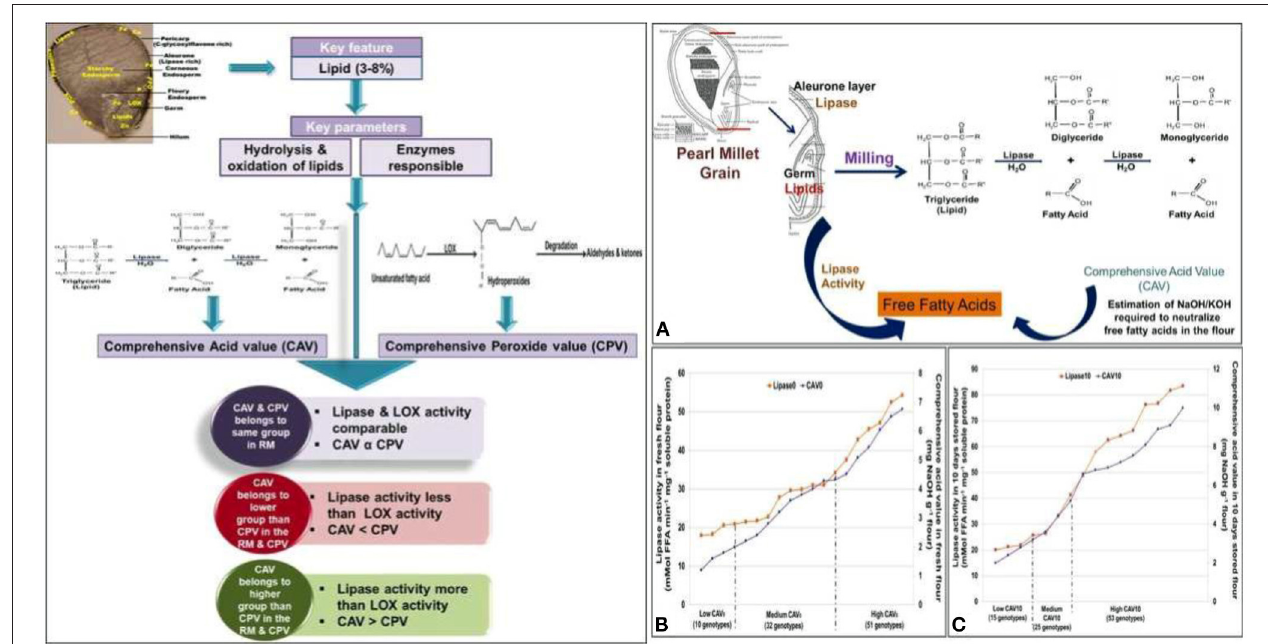
FIGURE 4 | Mechanism of action and role of lipase activity for shelf life in pearl millet flour (Adapted from: Goswami et al., 2020). (A) Correlation between lipase activity and comprehensive acid value (CAV). (B) Correlating the lipase activity and CAV of pearl millet genotypes in group I (freshly milled flour). (C) Correlating the lipase activity and CAV of pearl millet genotypes in group II (10-day stored